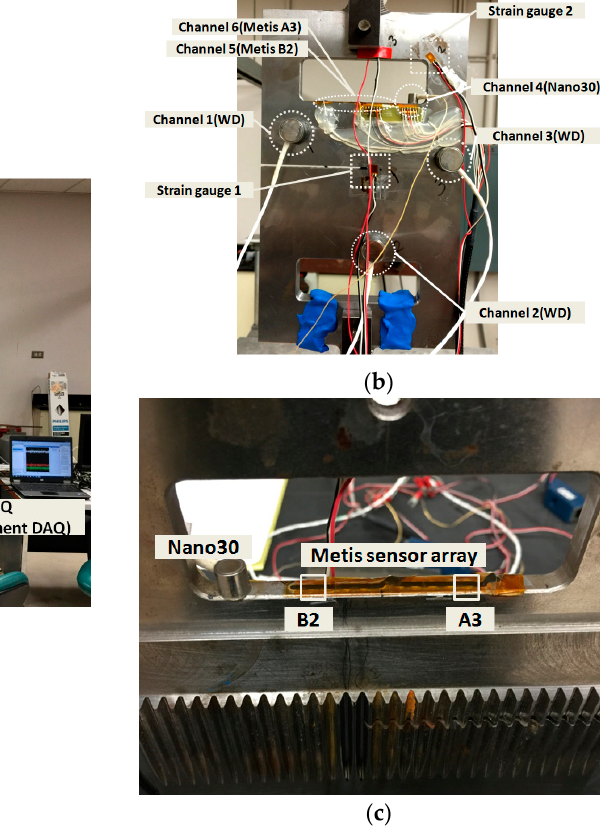
Figure 5. The experimental setup, ( a ) data acquisition systems; ( b ) the sensor positions; and ( c ) the sensors on the window section.